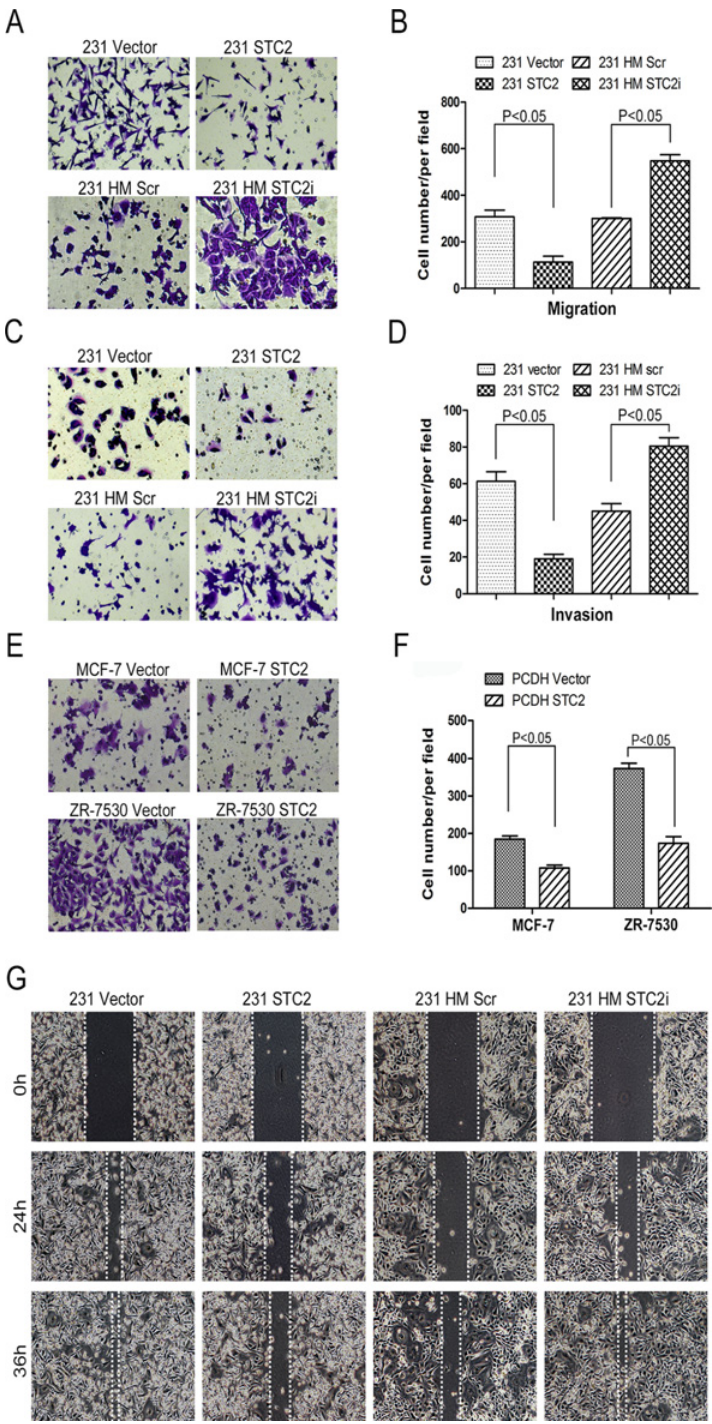
Fig 3. STC2 influences migration and invasion of breast cancer cells. A-B , Migration assays. A , Representative images of migrated cells. B , Quantitative analysis of the number of migrated cells. Five images were taken randomly for each experiment, and each experiment was repeated three times (P < 0.05). Error bars = 95% CIs. C-D , The invasion assay (P < 0.05). Error bars = 95% CIs. E-F , STC2 influences migration of breast cancer cells MCF-7 and ZR-75-30. E , Representative images of migrated cells. G , Quantitative analysis of the number of migrated cells (P < 0.05). Error bars = 95% CIs. G , Scratch-wound